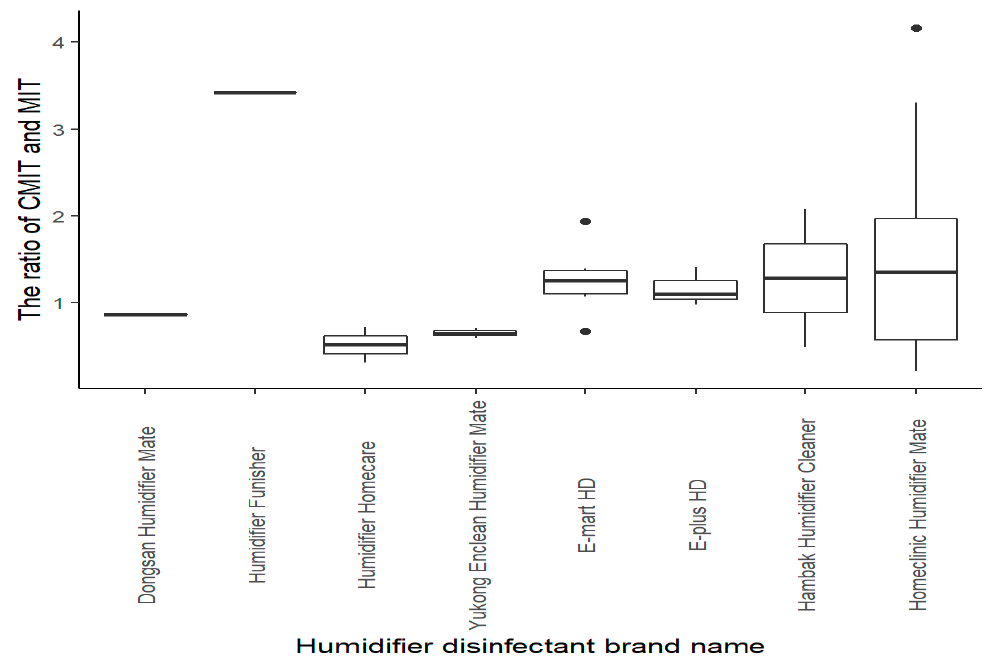
Figure 2. The distribution of the ratio of CMIT and MIT dissolved in HD by HD product (CMIT, 5-chloro-2methylisothiazol-3(2 H )-one; MIT, 2-Methylisothiazol-3(2 H )-one).